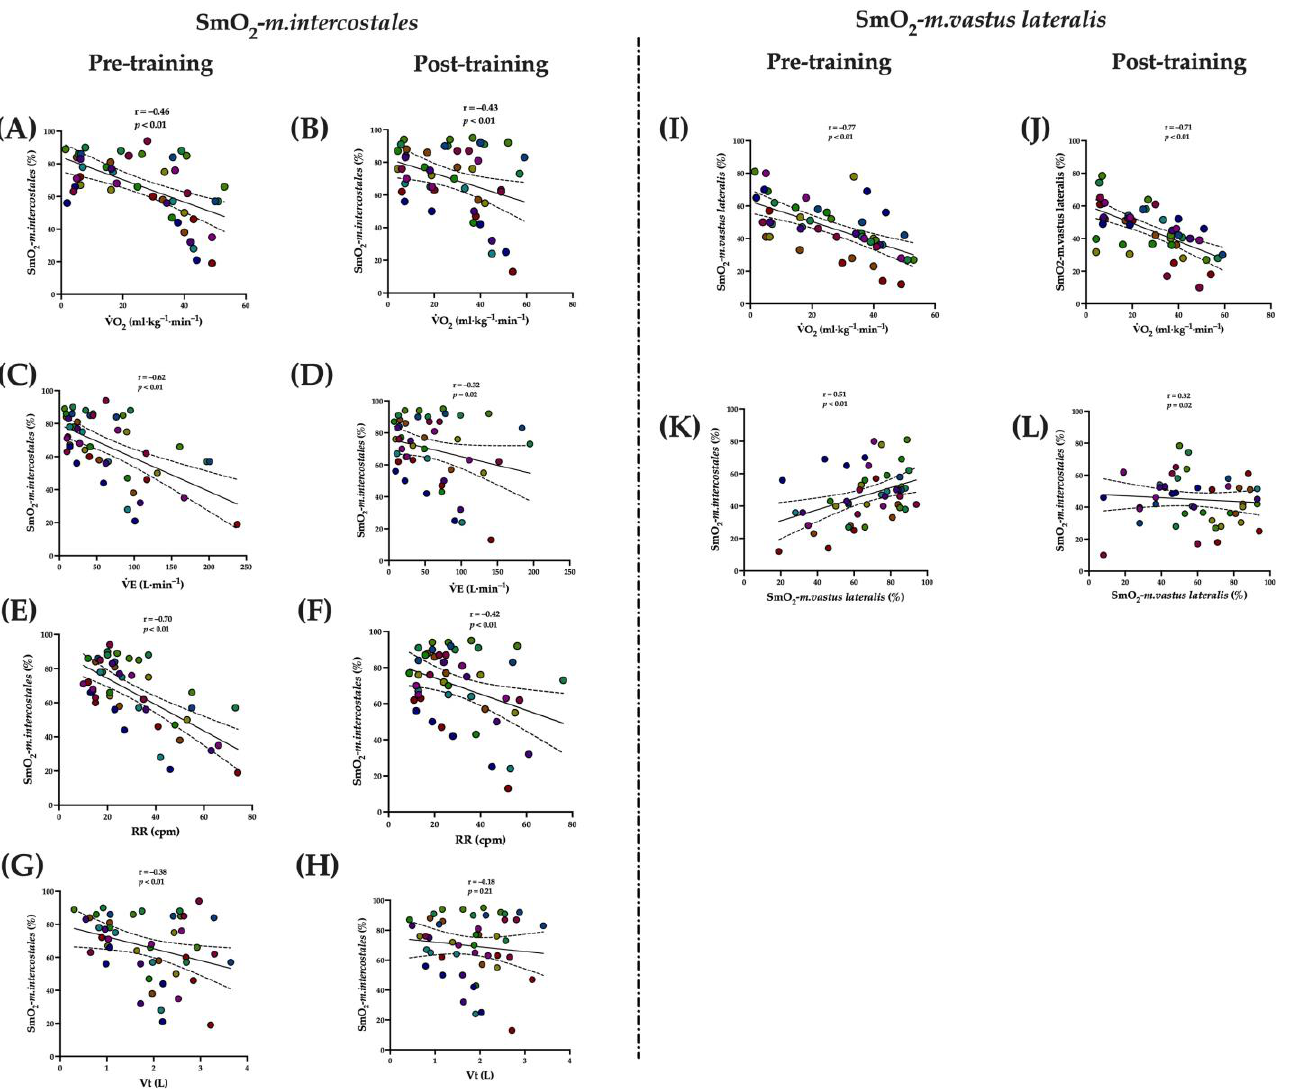
Figure 5. Correlations in ITL group of SmO 2 - m. intercostales (%) with V̇ O 2-peak (ml·kg − 1 ·min − 1 ) in pre- ( A ) and post-training ( B ); V̇ E (L·min − 1 ) in pre- ( C ) and post-training ( D ); RR (bpm) in pre- ( E ) and post-training ( F ); and Vt ( L ) in pre- ( G ) and post-training ( H ). Correlation in VIH group of SmO 2 - m.vastus lateralis (%) with V̇ O 2-peak (ml·kg − 1 ·min − 1 ) in pre- ( I ) and post-training ( J ); and SmO 2 - m. intercostales (%) in pre- ( K ) and post-training ( L ). Abbreviations: SmO 2 = muscle oxygen saturation; V̇ O 2-peak = peak oxygen uptake; VE = lung ventilation; RR = respiratory rate; Vt = tidal